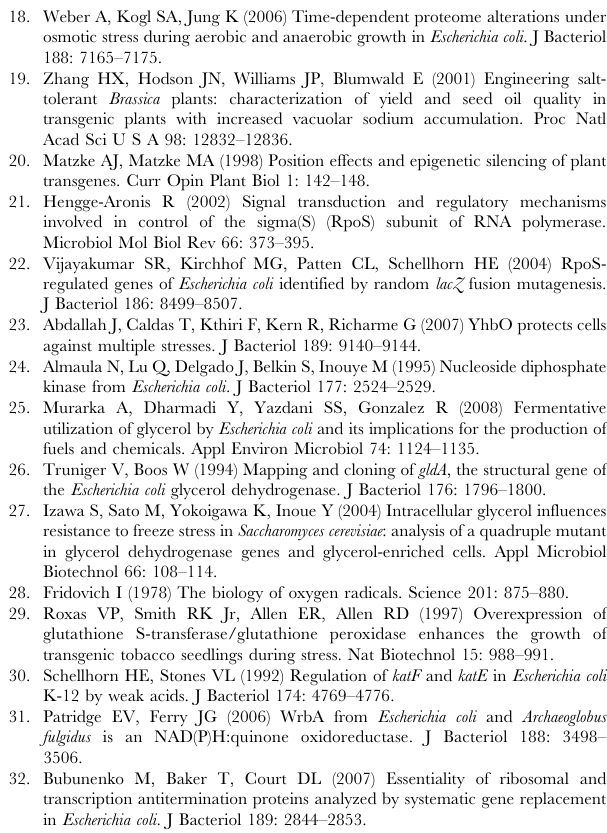
Table S2 Downregulated proteins of the E. coli strain expressing IrrE versus the control strain carrying only the pMG1vector in